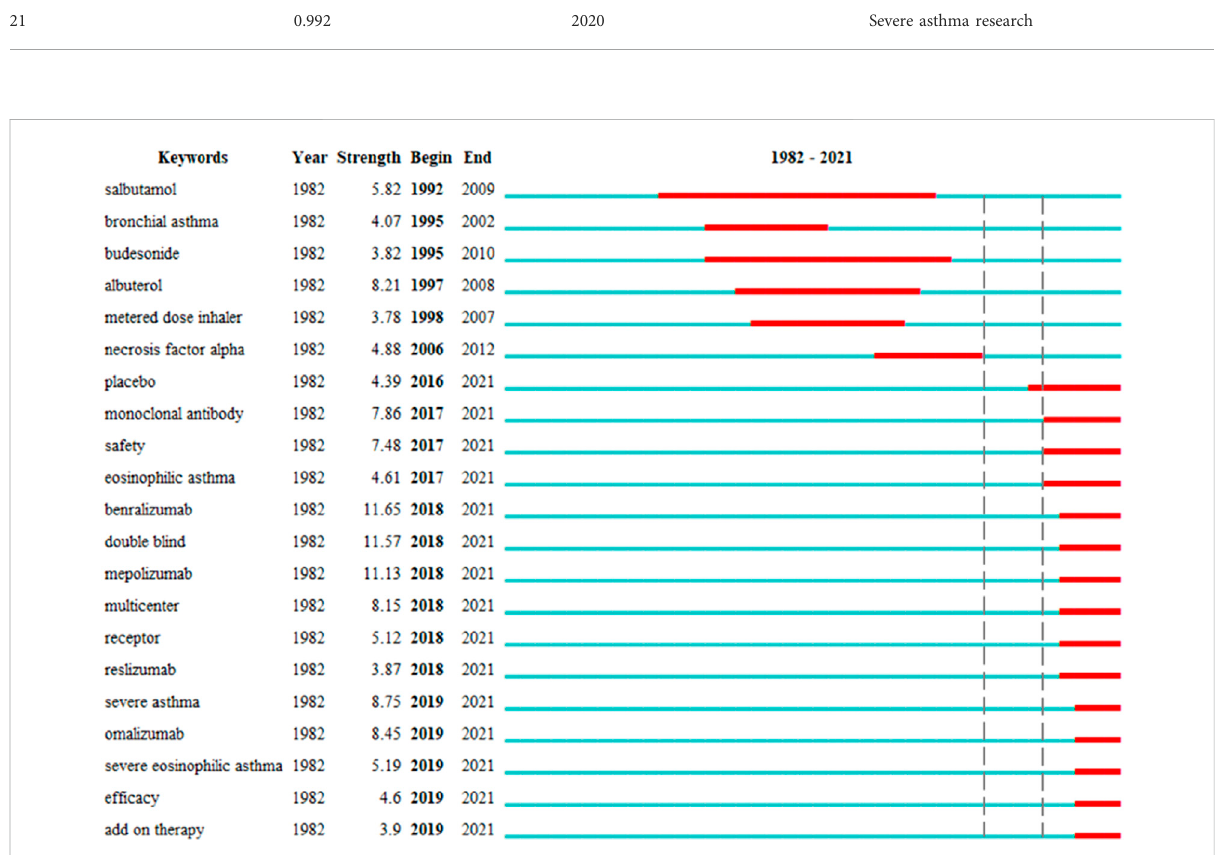
FIGURE 8 Top 21 keywords with strongest citation bursts in severe asthma drug-related